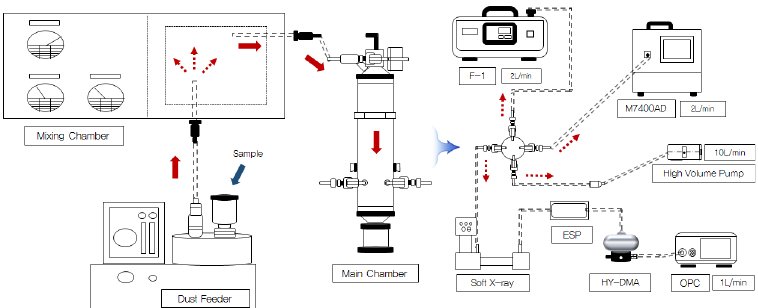
Fig 1. Schematic diagram comparing various asbestos measuring